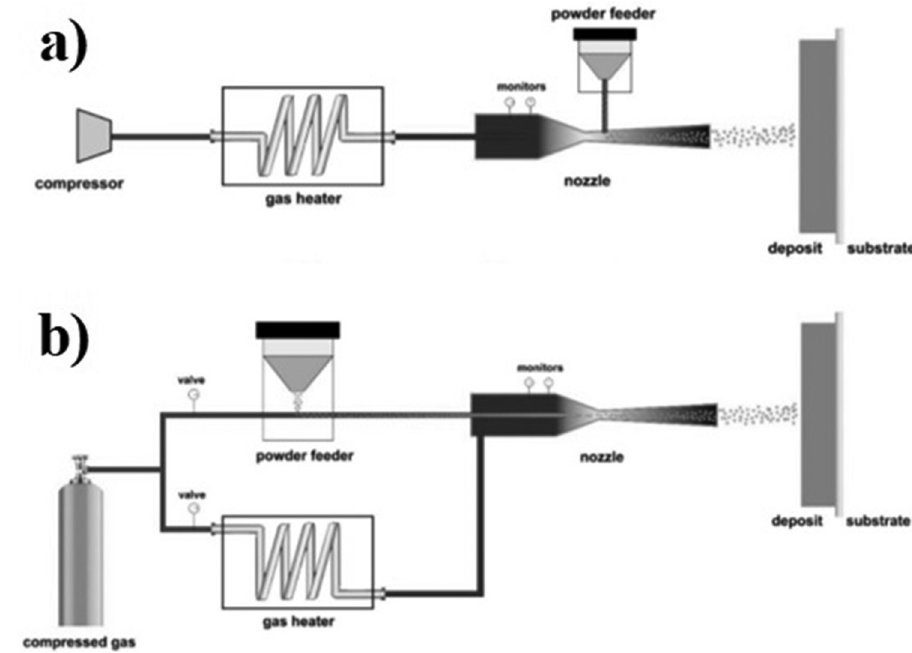
Figure 2: Schematic CS coating system: ( a ) LPCPS and ( b ) HPCPS [ 1 ] .